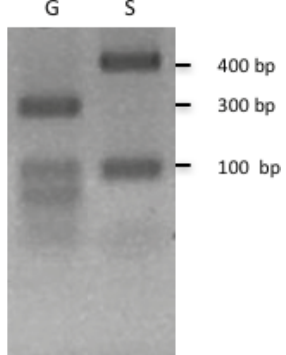
Figure 2. Typical restriction patterns obtained by double digestion of PCR product corresponding to a portion of the calmodulin gene from A. solani and A. grandis. Size of the larger fragment, 420 bp for A. solani sensu lato (S) and 292 bp for A. grandis